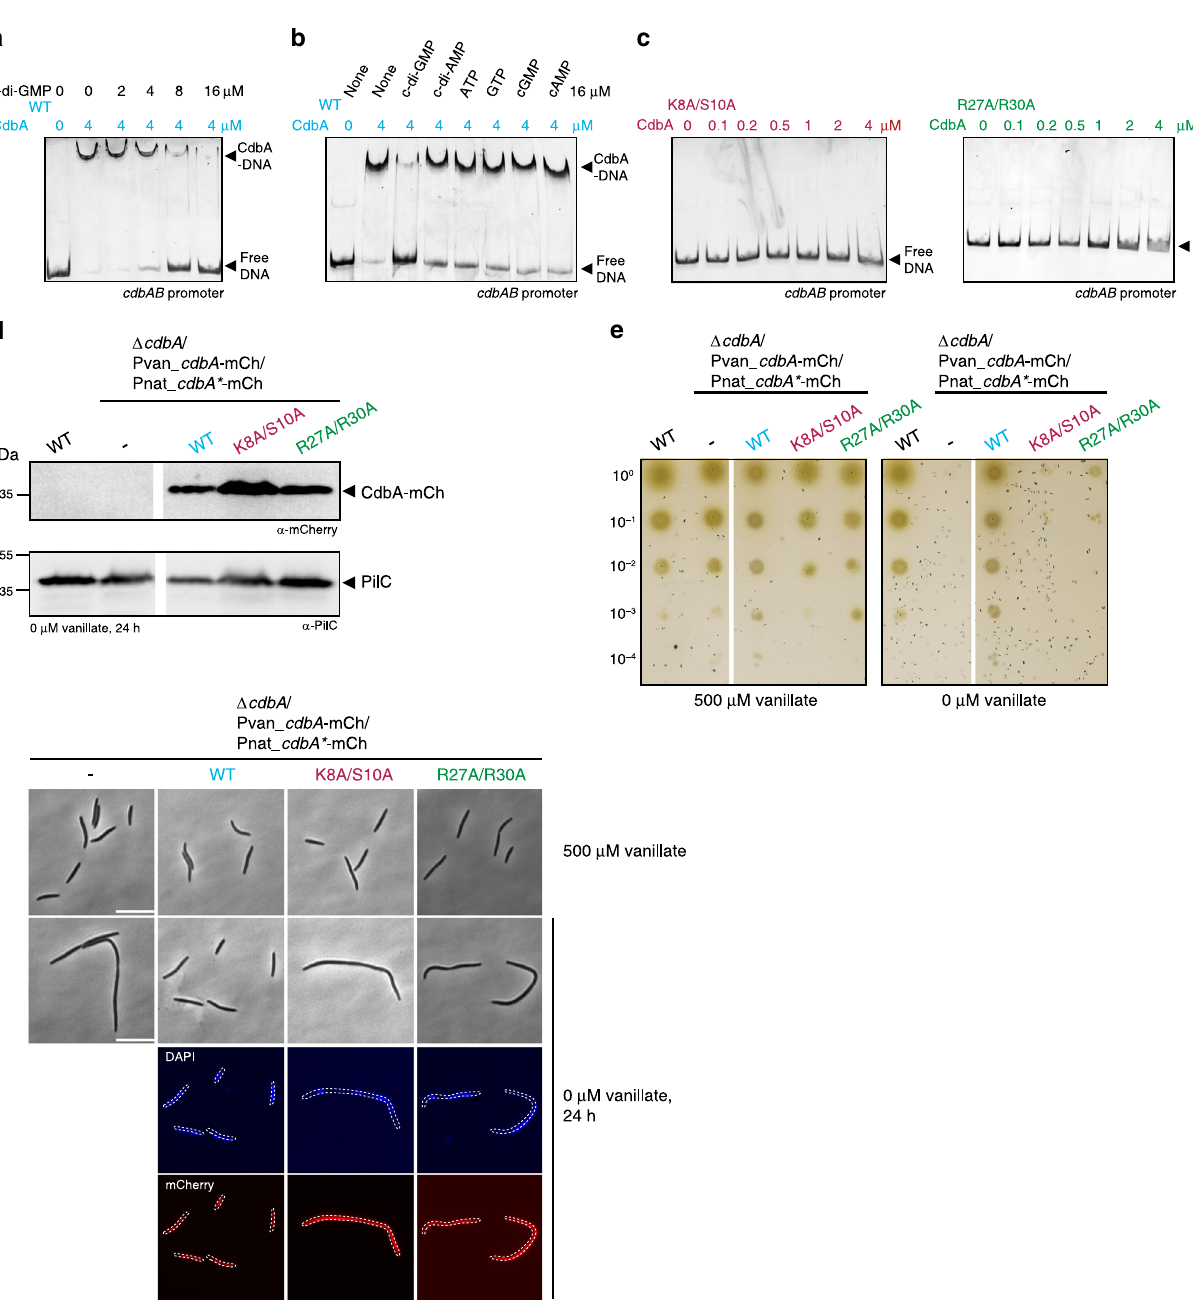
Fig. 7 C-di-GMP and DNA binding is mutually exclusive and essential for CdbA function in vivo. a EMSA experiment with CdbA in the presence of c-di- GMP. The fragment used covers the cdbAB promoter (see also Fig. 5a). 4 µ M CdbA was incubated with indicated concentrations of c-di-GMP for 10